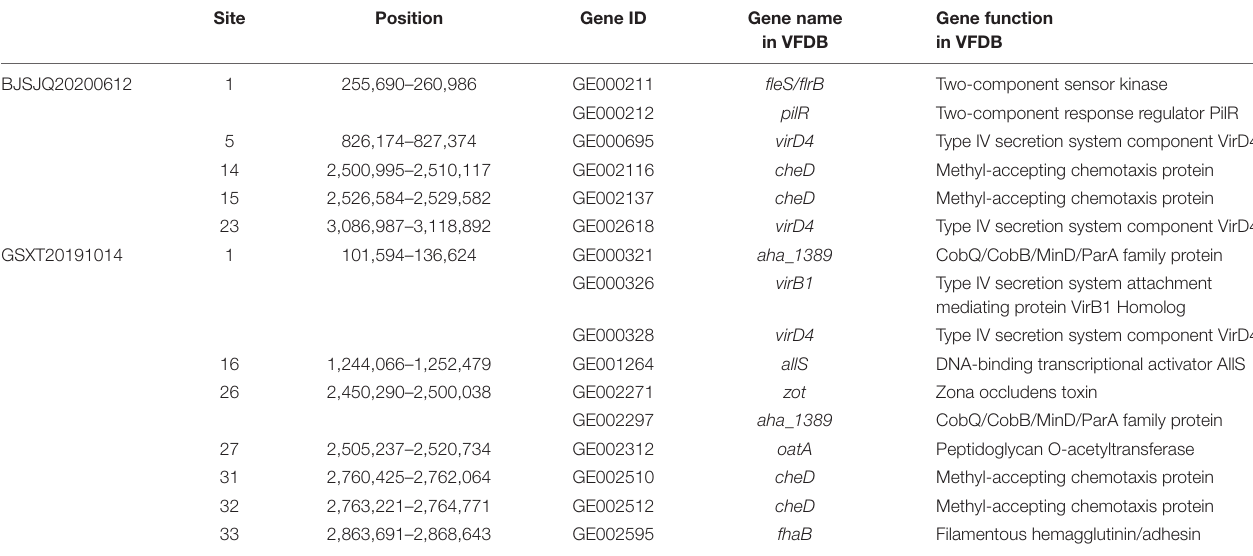
TABLE 2 | The virulence factors in the variable genomic regions of BJSJQ20200612 and GSXT20191014 genomes according to the VFDB database. Site Position Gene